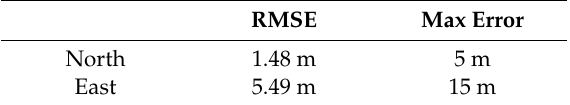
Table 1. This table shows the root mean square error (RMSE) and the max errors for the Air-Odo/INS integration performance during 65 sec of Global Navigation Satellite Systems (GNSS) outage.